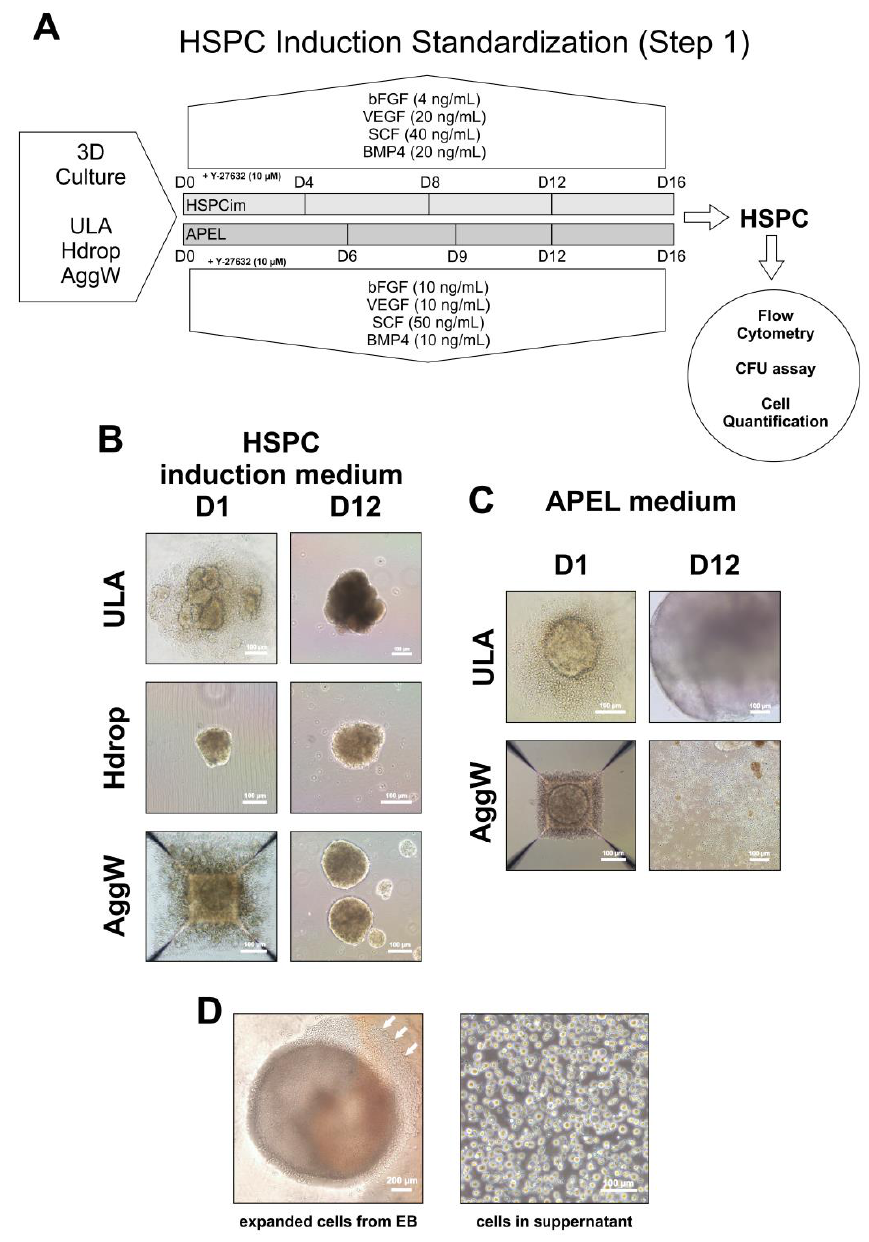
Figure 2. Workflow of the Hematopoietic Stem Progenitor Cell (HSPC) induction methods (Step 1), using different 3D culture methods, basal media, and supplements ( A ). Representative images of EBs formed on D1 and D12 using HSPCim in three different aggregation methods ( B ). Representative images of EBs formed on D1 and D12 using APEL in two different aggregation methods ( C ). Representative image of cells sprouting (white arrows) from an EB and expansion in the supernatant ( D ). HSPCim: Hematopoietic Stem/Progenitor Cell induction medium.